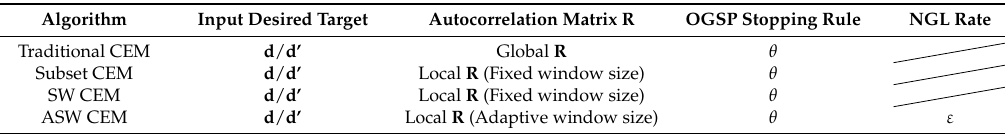
Table 1. Parameter settings of different